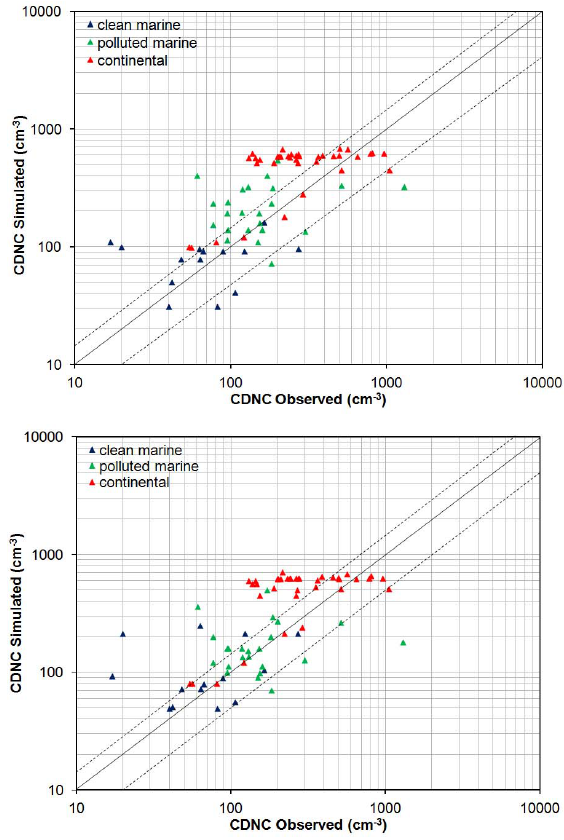
Fig. 5. Comparison of GMI (top panel) and GEOS-Chem (bottom panel) simulated global CDNC against observational data (which are sorted by region). Also shown are the 1 : 1 and ± 50%